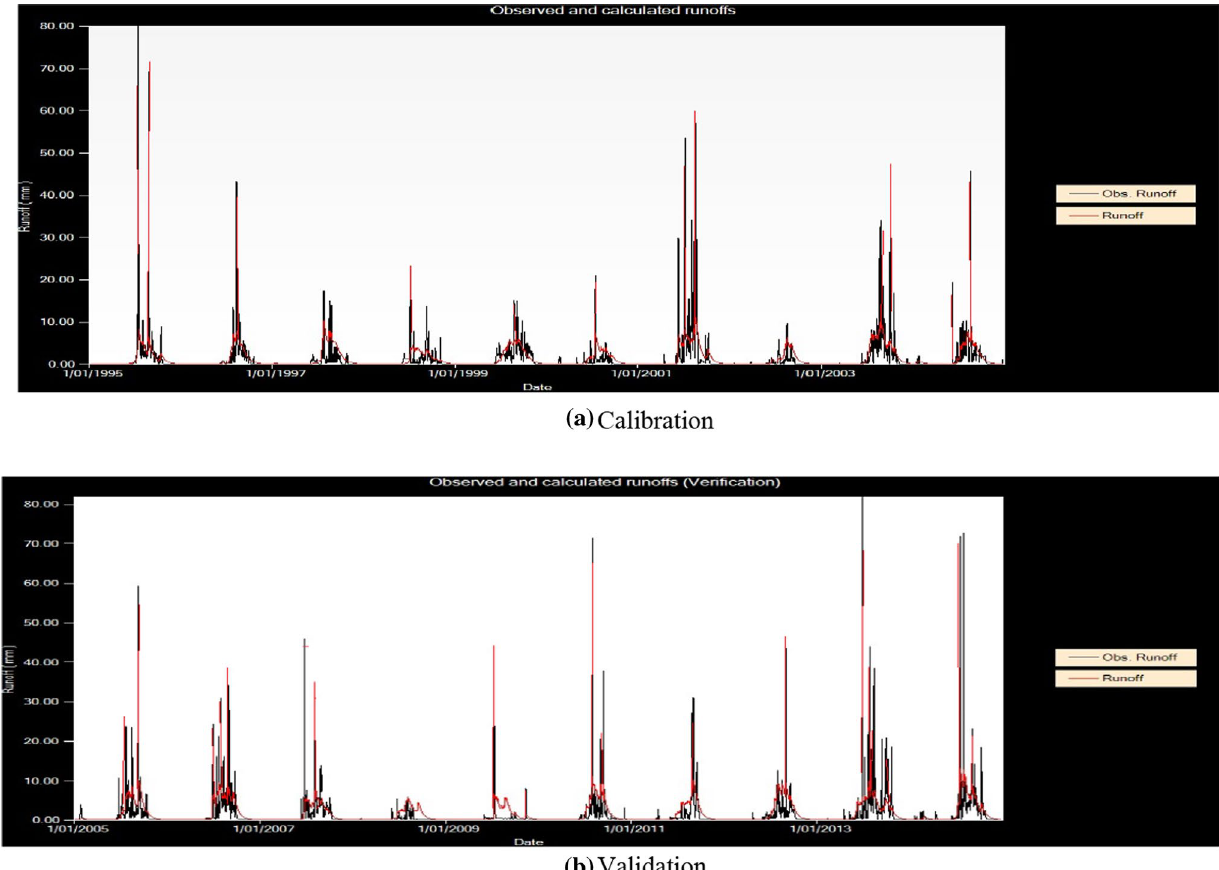
Fig. 5 Observed and simulated runoff from